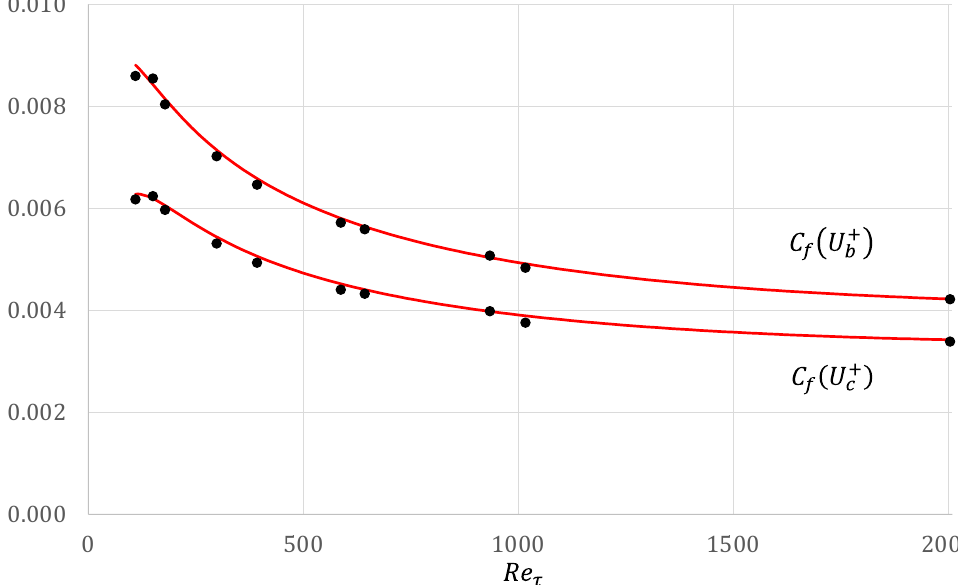
Fluids 2023 , 8 , x FOR PEER REVIEW